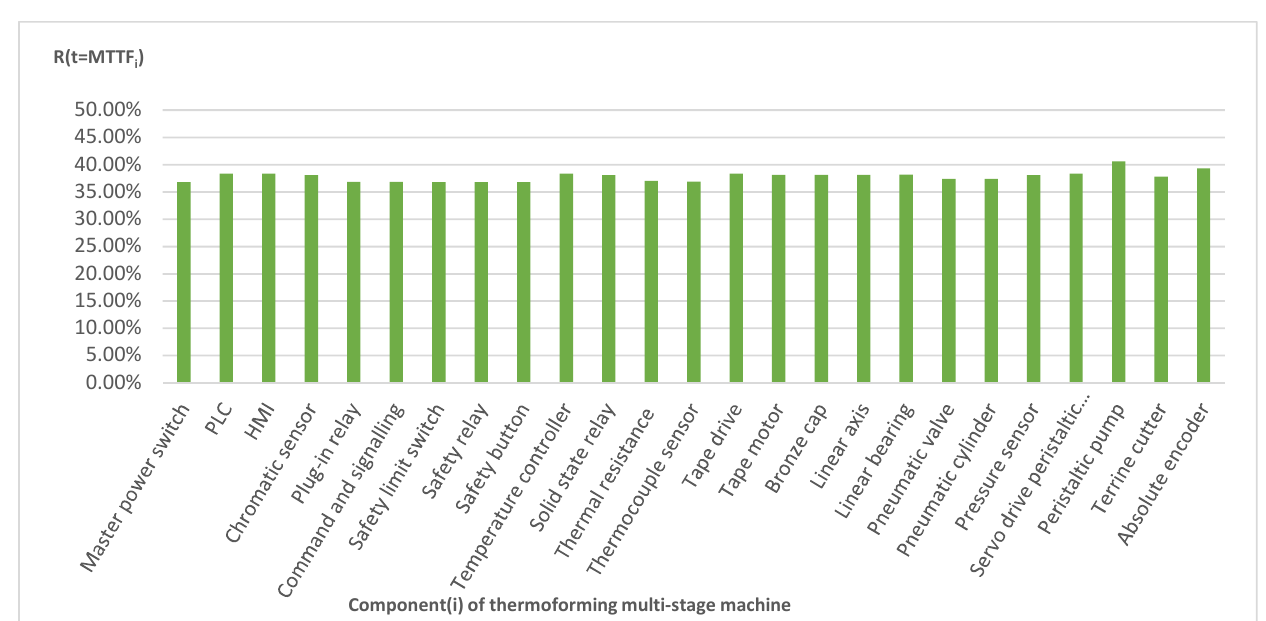
Figure 4. Reliability calculated at MTTF with the exponential function (6) in the PPM strategy.